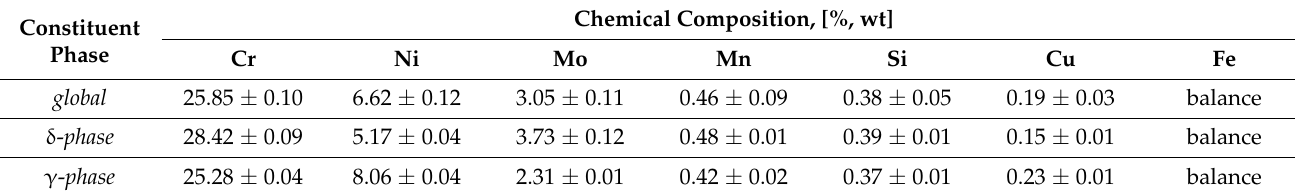
Figure 2. SEM-EDS colorized maps showing the main alloying elements distribution in the AR UNS S32750 Super-Duplex Stainless Steel: SEM-BSE image of the microstructure ( a ); distribution map of Cr ( b ); Ni ( c ); Mo ( d ); Mn ( e ); Si ( f ); Cu ( g ). Table 1. The average chemical composition of the AR UNS S32750 Super-Duplex Stainless Steel.